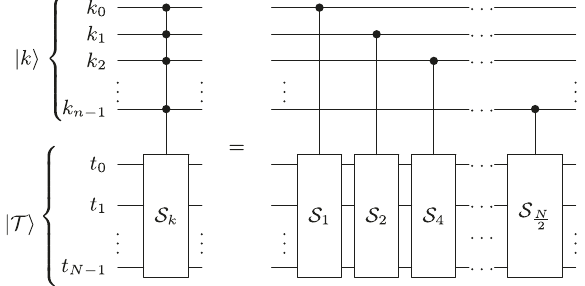
Fig. 1 Circuit diagram for circular bitwise rotation operator S k . A shift by k bits can be achieved by a product of log ð k Þ controlled shift operations.